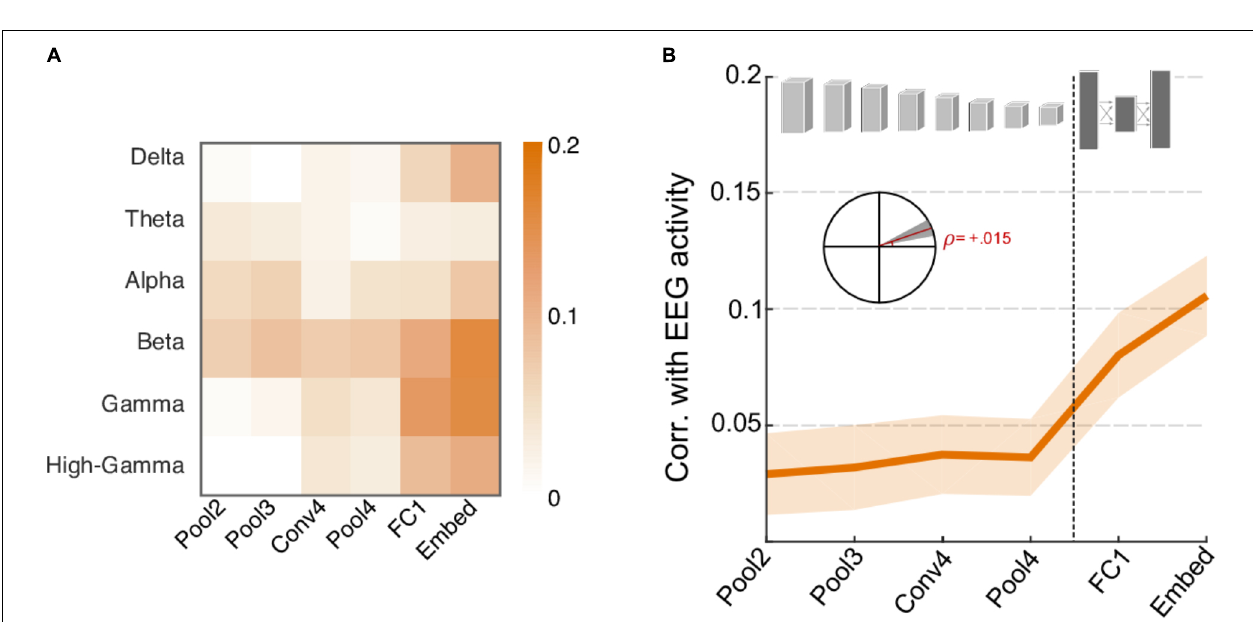
FIGURE 6 | Analysis of dense vs. sparse scenes. (A) Difference in correlation between salience and CNN activity for dense and sparse scenes. Negative values indicate that salience in sparse scenes was more highly correlated with CNN activity. (B) Difference in correlation between acoustic features and CNN activity for dense and sparse scenes.